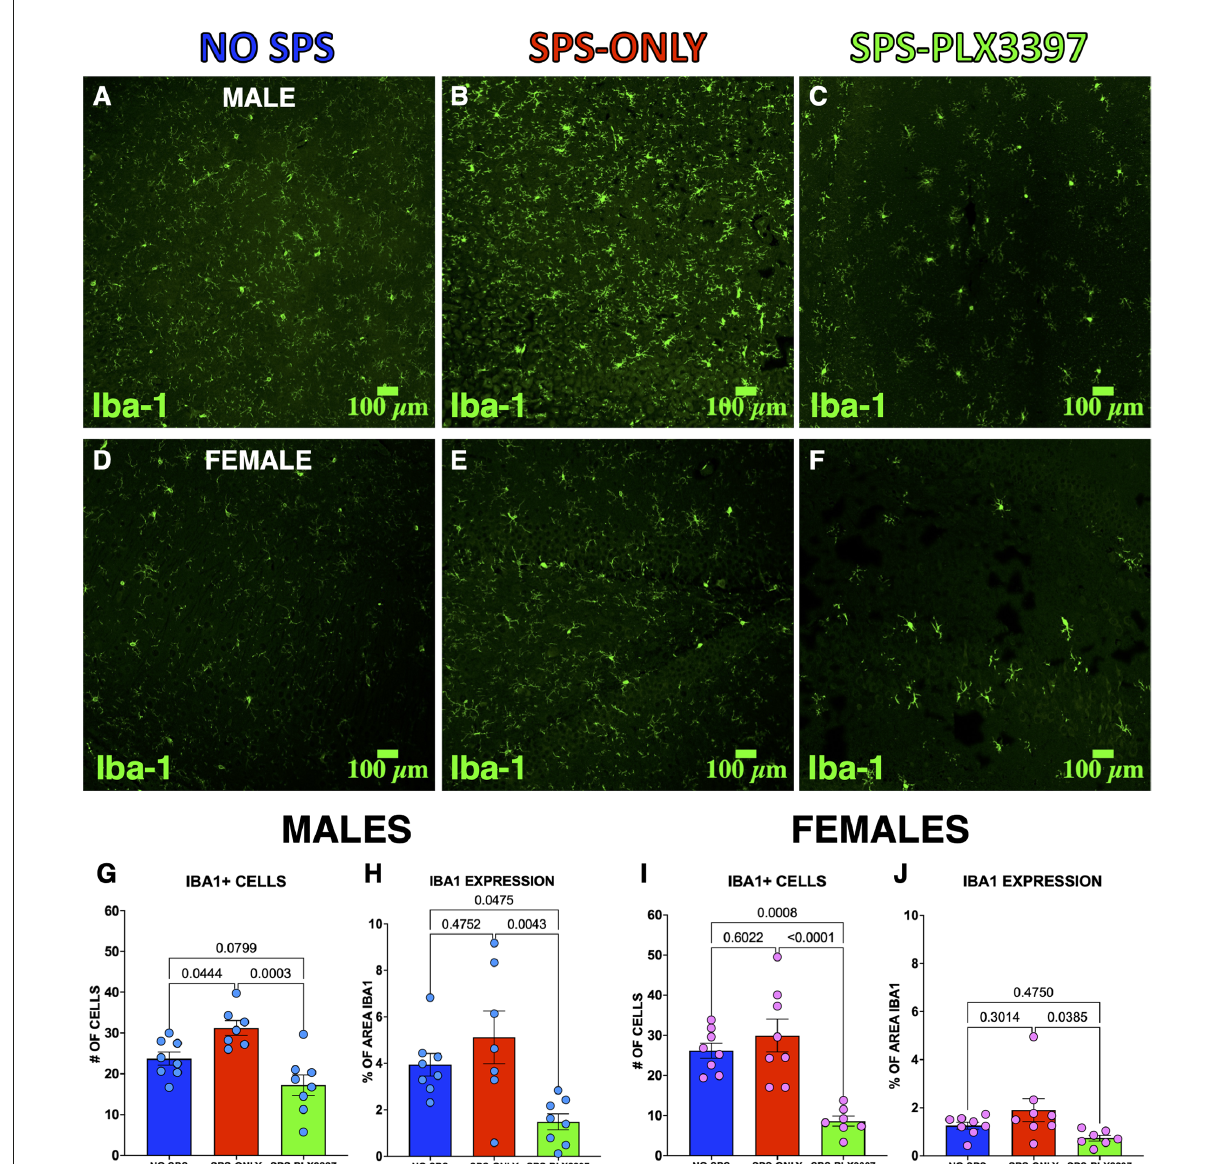
FIGURE3 PLX3397 reduced the number of Iba-1+ cells in the ventral hippocampus in both male and female rats. (A–C) Representative images of Iba1-labeledventralhippocampalslicesof (A) NOSPS, (B) SPS-ONLY,and (C) SPS-PLX3397malerats. (D–F) RepresentativeimagesofIba1-labeled ventral hippocampal slices of (D) NO SPS, (E) SPS-ONLY, and (F) SPS-PLX3397 female rats. (G,H) Iba-1+ cells and Iba1 area fraction in the ventral hippocampus of male rats. (I,J) Iba-1+ cells and Iba1 area fraction in the ventral hippocampus of female rats. One-way ANOVA, Tukey’s multiple comparisons